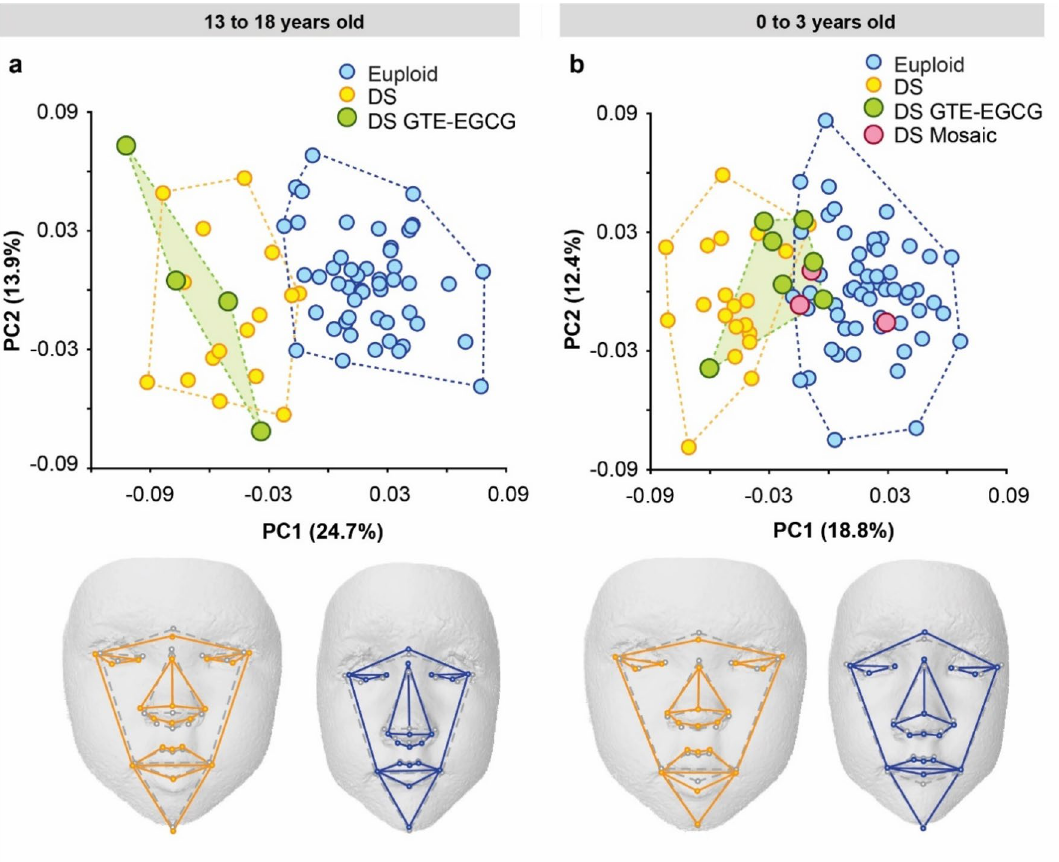
Figure 3. Principal Component Analyses of the global facial shape variation in human children from different age groups. ( a ) Adolescents from 13 to 18 years old, and ( b ) Babies/toddlers to 3 years old. Scatterplots of PC1 and PC2 axes with the corresponding percentage of total morphological variance explained are displayed along each axis. Convex hulls represent the ranges of variation within each group of children. Anterior facial morphings associated with the extreme negative and positive values of PC1 are also shown. Orange solid lines represents facial phenotypes associated with Down syndrome, whereas blue solid line represents facial phenotype associated with euploid condition. Both shapes are compared to average facial shape, represented by a dashed grey line. Facial reconstructions were obtained from 3dMD and Agisoft PhotoScan, landmarks were recorded with PhotoModeler and morphings performed with